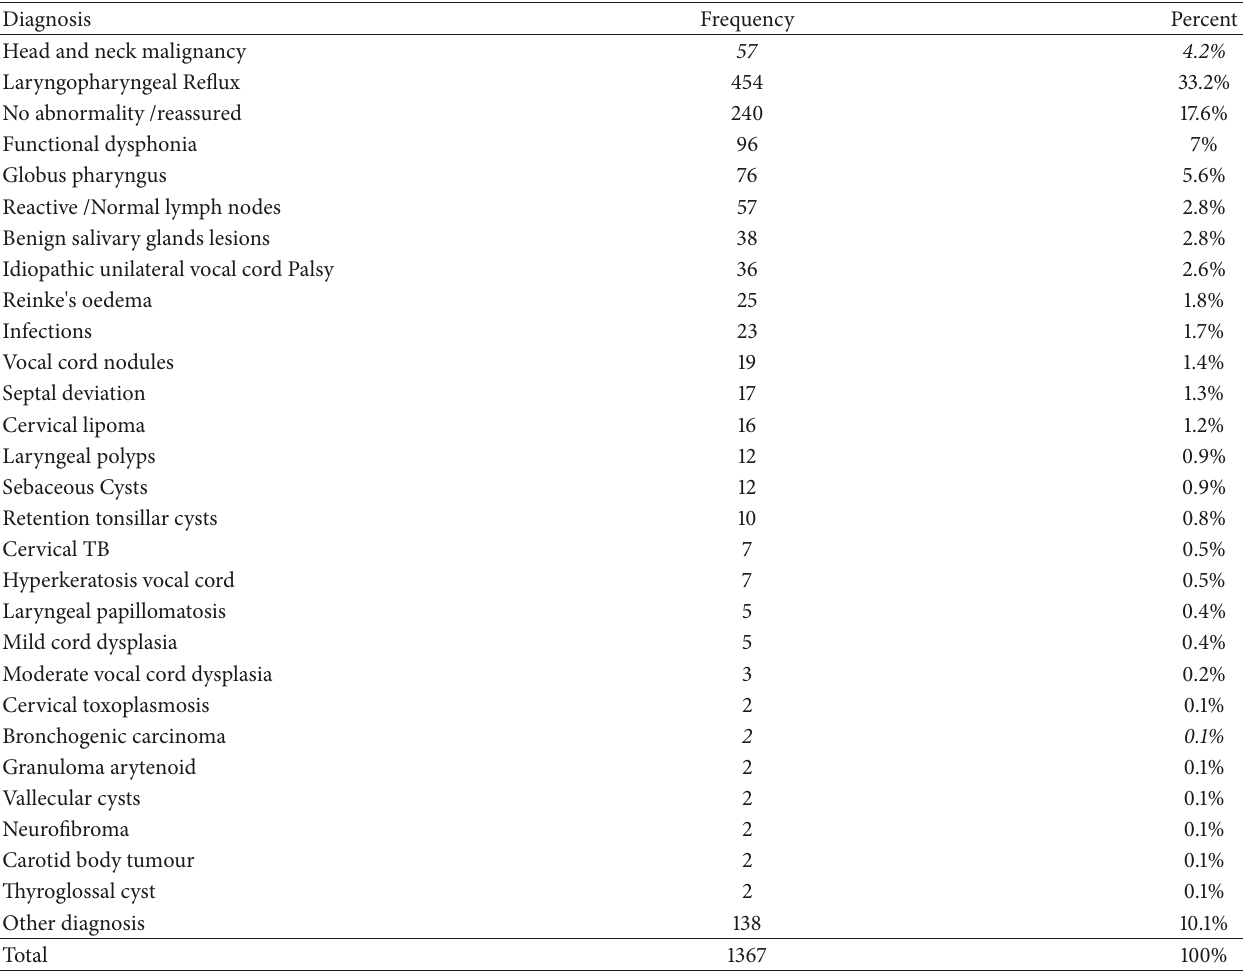
Table 4: Final diagnosis of patients referred through 2 ww pathway.